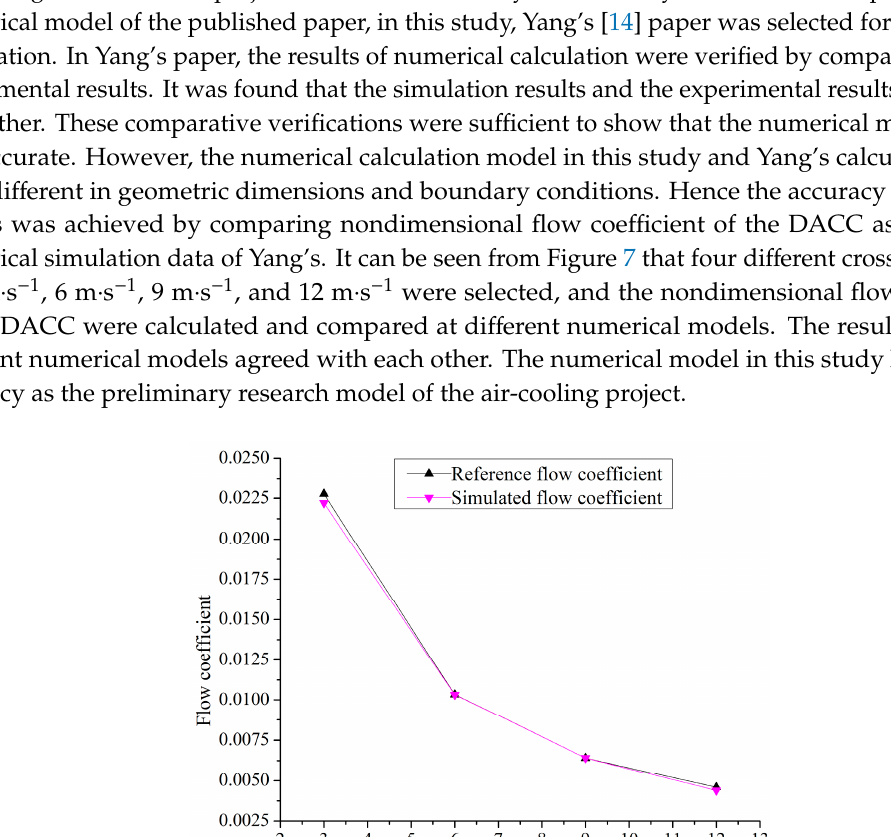
Figure 6. Air flow rate of fans at the crosswind of 4 m·s − 1 .